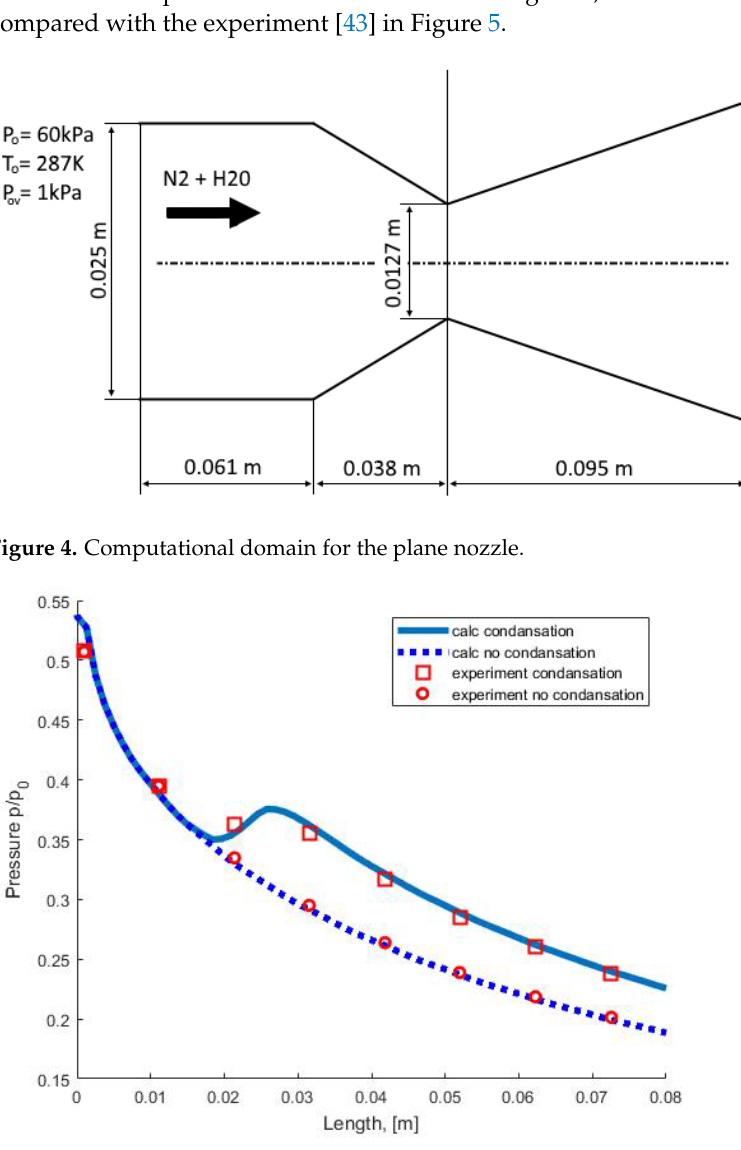
Figure 5. Pressure distribution along the nozzle